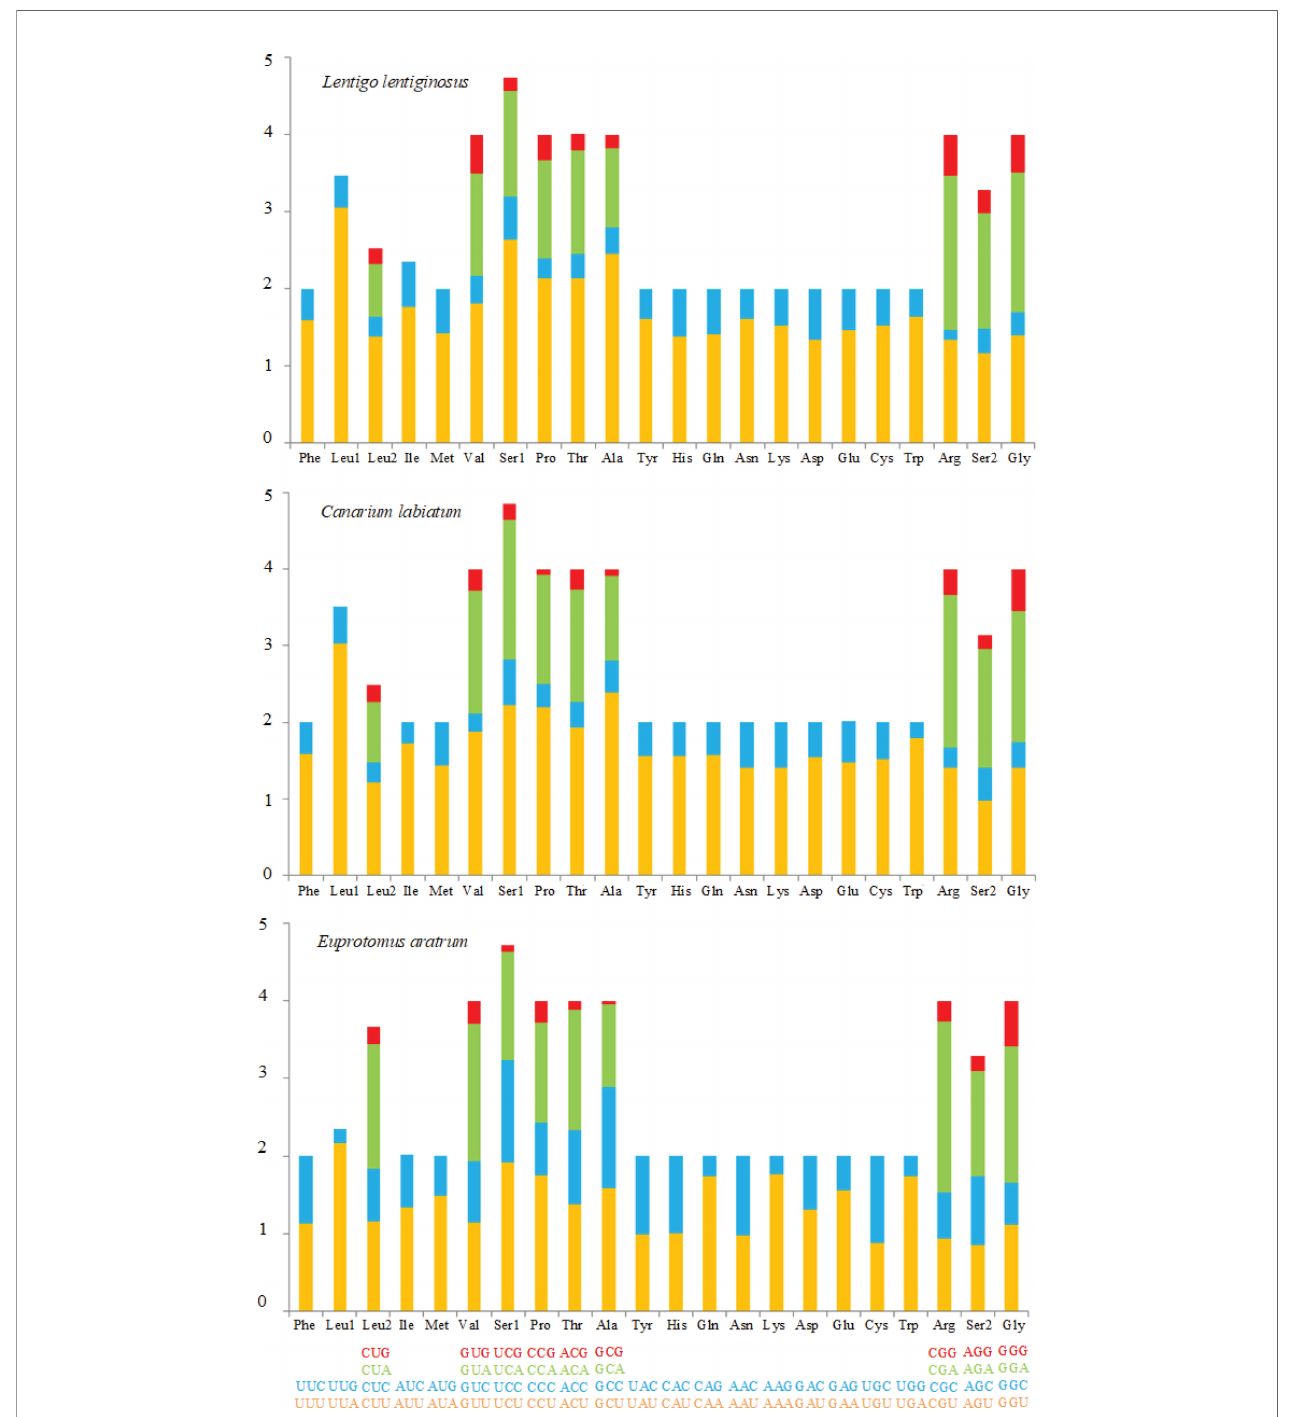
FIGURE 2 | Relative synonymous codon usage (RSCU) of mitochondrial genomes for Lentigo lentiginosus , Canarium labiatum , and Euprotomus aratrum